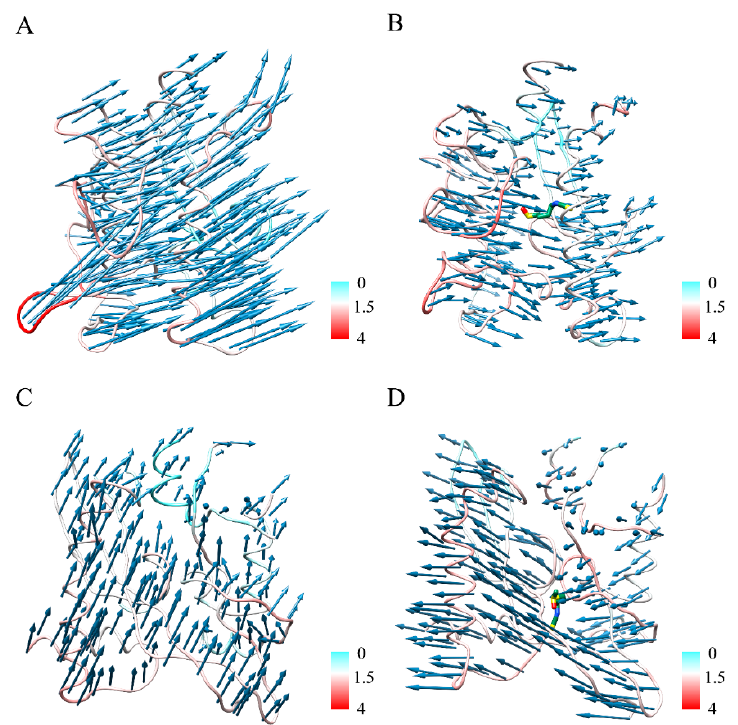
Figure 5. Vector field representations of the first principal component (PC) obtained in the ( A ) S closed , ( B ) SFN-S closed , ( C ) S open , and ( D ) SFN-S open systems. The colors of the residues indicate the root-mean- square fl uctuation (RMSF) values (units in Å).